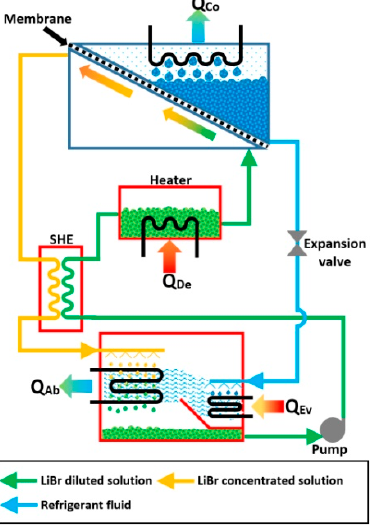
Figure 3. Membrane absorption system described by Riffat et al. [48].